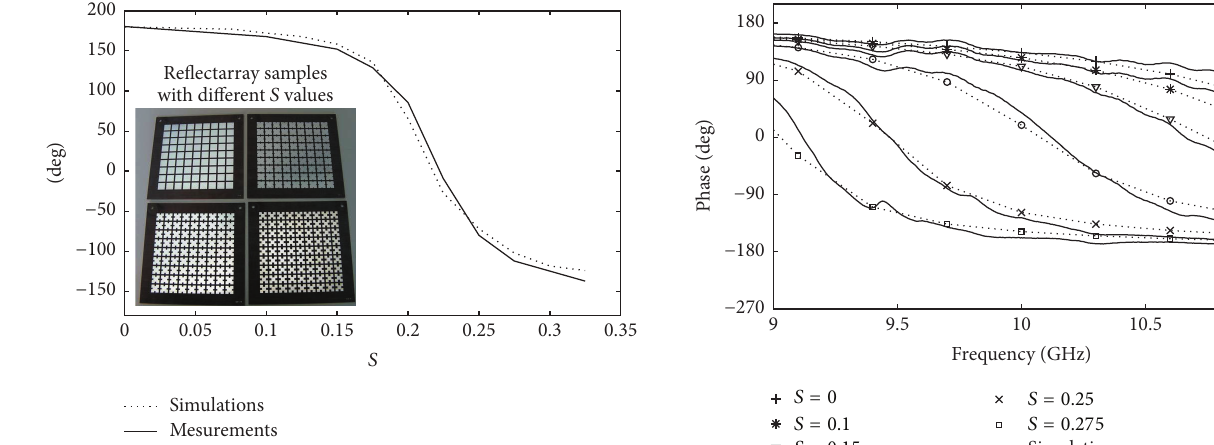
Figure 17: Comparison between simulated and measured phase curves versus 𝑆 ( 𝐿 = 7.6 mm, Δ𝑥 × Δ𝑦 = 0.3𝜆 0 × 0.3𝜆 0 , and = 10 GHz). Figure 18: Comparison between simulated and measured phase 𝑓 0